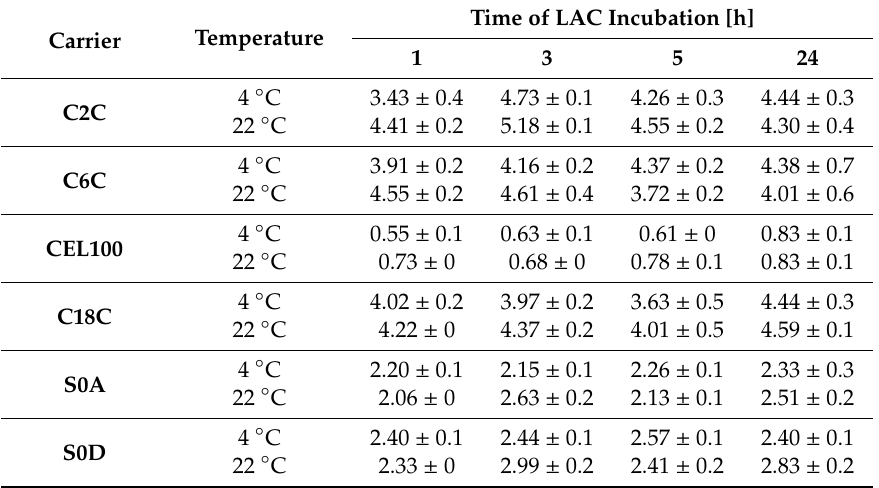
Table 3. Influence of the temperature on the activity [U / g] of covalently immobilised LAC from P. ostreatus during 24-h incubation.